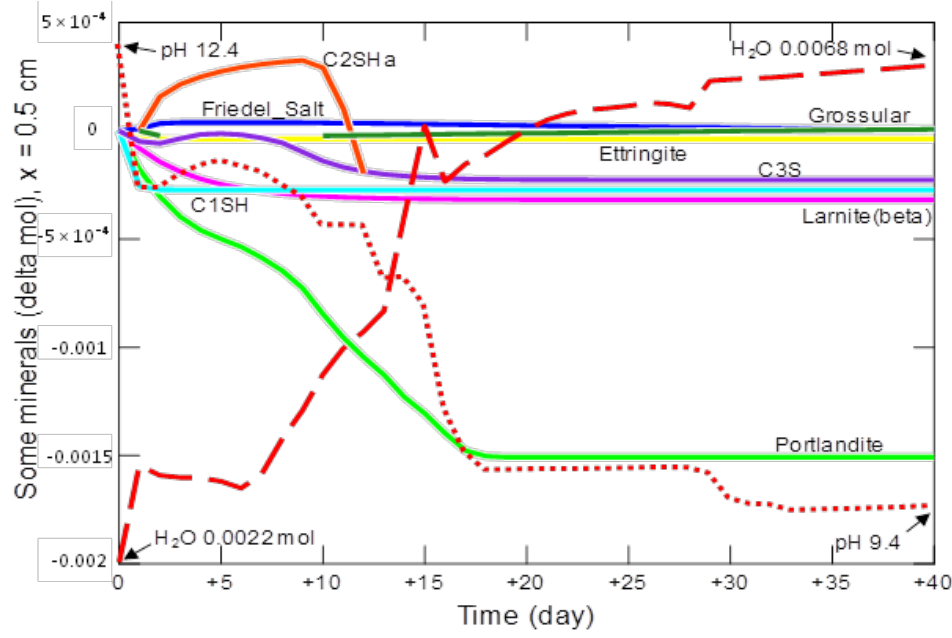
Figure 20. Changes in the amount of water, mineral phases and pH in the cement matrix at a distance of 0.5 cm, from the beginning of the model domain, in conditions of ammonium chloride penetration.